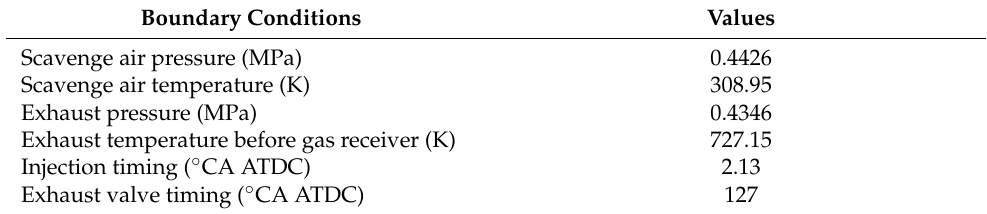
Table 6. Boundary conditions in the